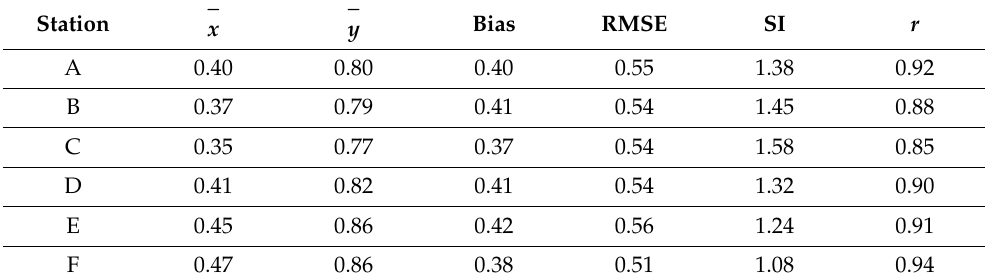
Table 6. Summary of statistical metrics between “observed values” and “hindcast parameters”.